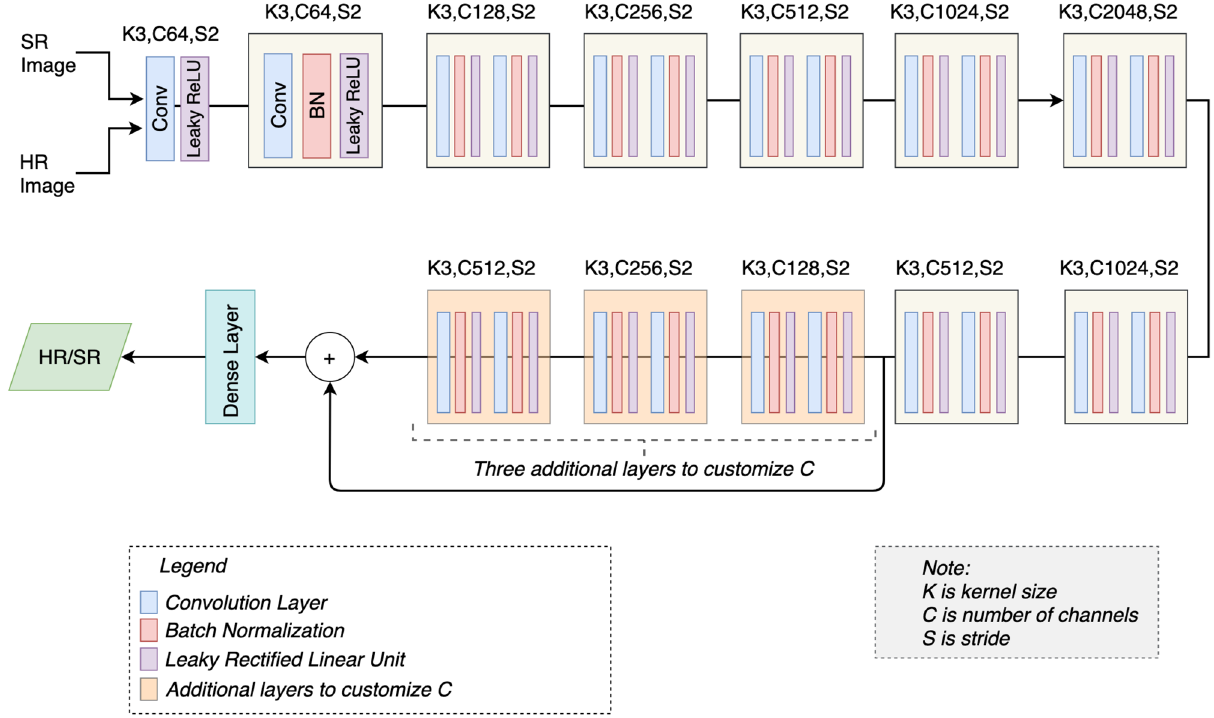
Figure 5. Discriminator network: proposed discriminator network to classify a given input image as an HR or SR image. K shows the kernel size, C shows number of kernels and S shows the stride. Three additional layers having the number of kernels equal to 128, 256 and 512 are added to perform elementwise addition with the parameters of the previous